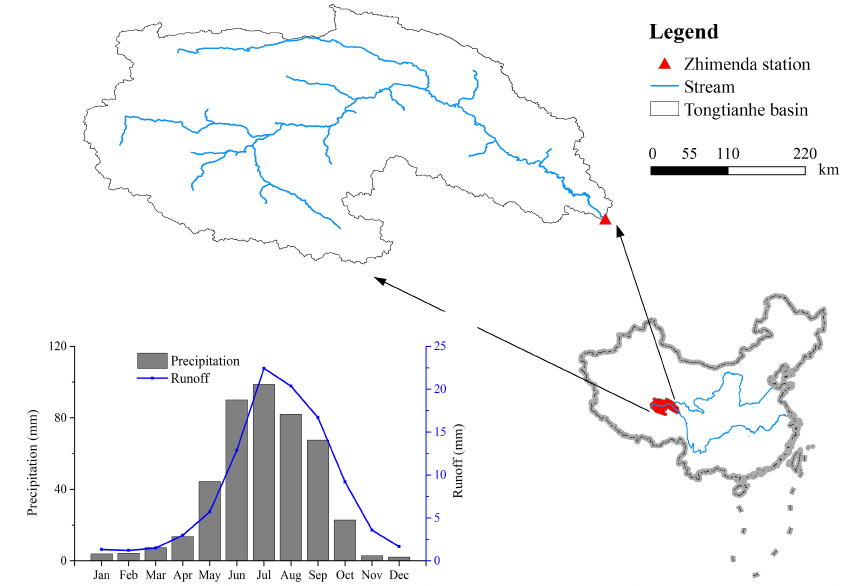
Figure 2. Location and mean monthly precipitation and runoff from 1980 to 2013 of the Tongtianhe basin.